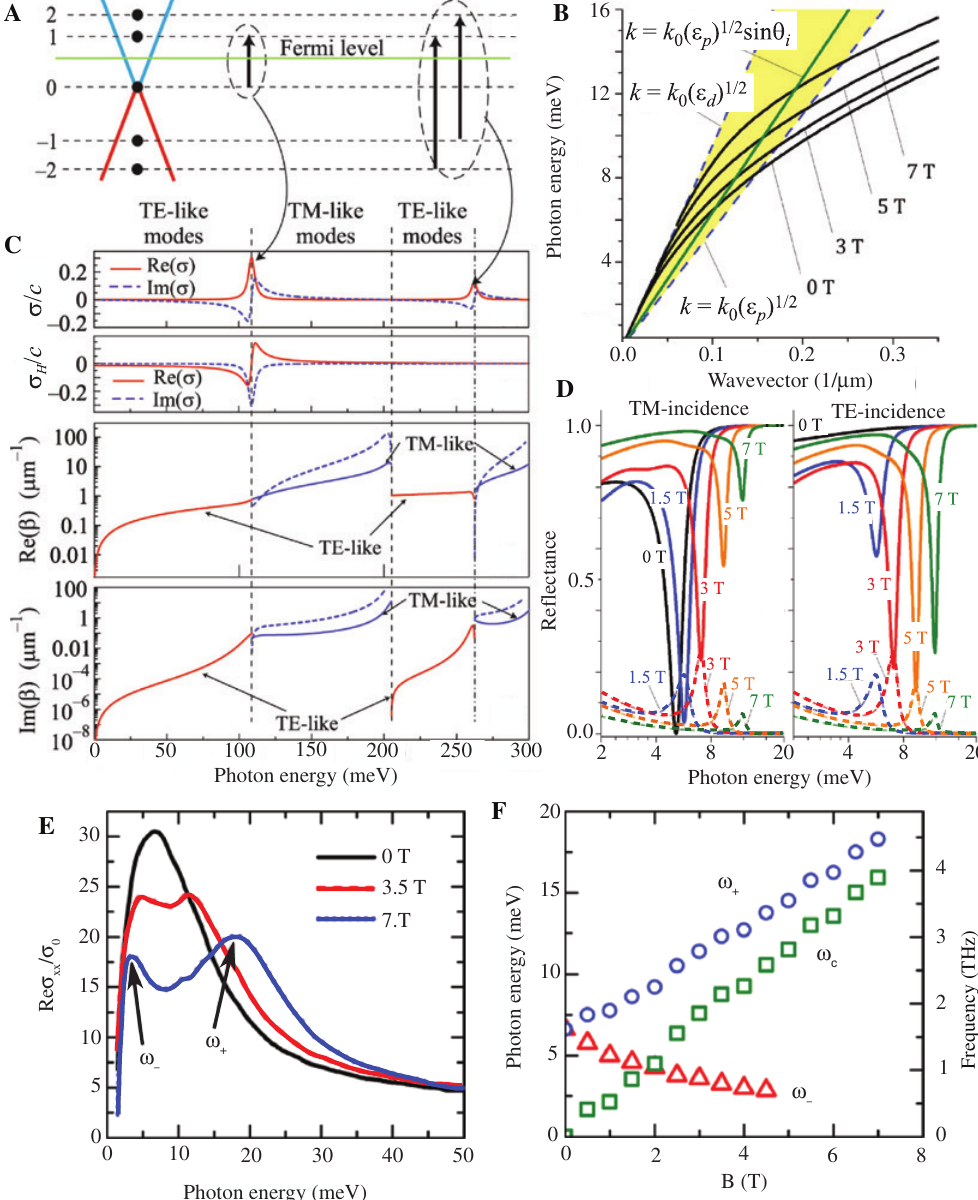
Figure 5: Magneto-plasmons in graphene. (A) The scheme of Landau levels in graphene. (B, C) dispersion curves of the magneto-plasmon-polaritons for different values of an external magnetic field. (D) Magneto-plasmon-polaritons in magnetically biased graphene in Otto configuration can be excited by both TE and TM incident wave. In the left panel, the incident wave is TM polarized, and the solid (dashed) lines correspond to TM (TE) reflectance. In the right panel, the incident wave is TE polarized, and the solid (dashed) lines correspond to TE (TM) reflectance. (E, F) Magnetically biased gra- phene disks may support bulk ( ω ) and edge ( ω ) magneto-plasmons (see text for details). Adapted from [87] (A, C), [88] (B, D) and [89] (E, + −